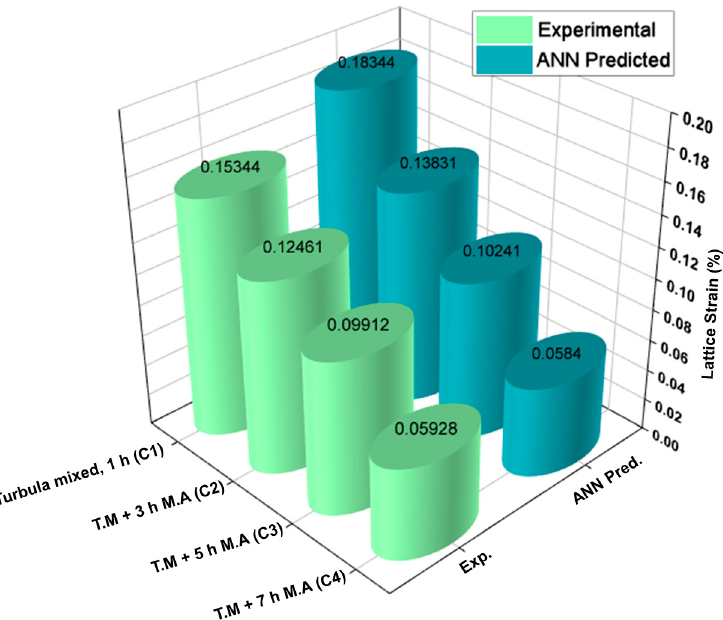
Figure 16. Variation in crystallite size for the experimental and ANN-predicted values as a function of milling time.